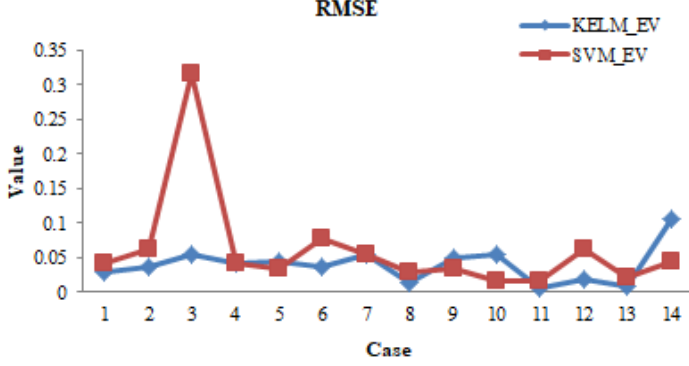
Figure 5. Changes of root mean square error (RMSE).